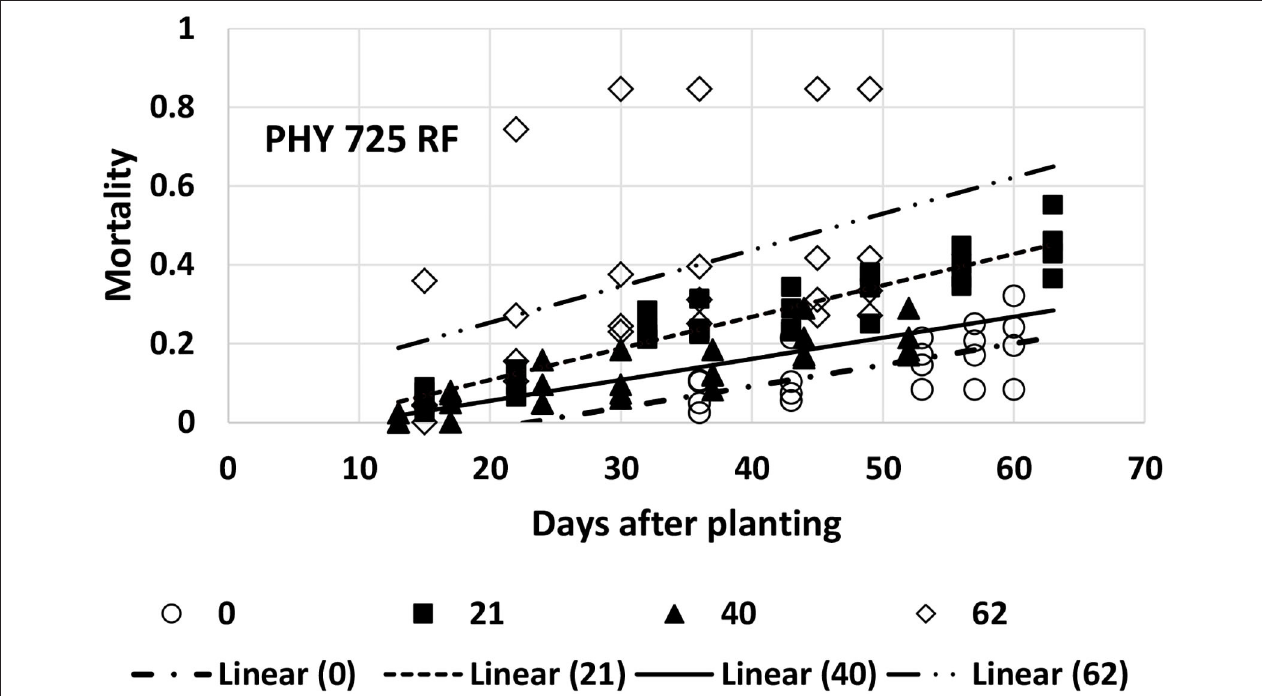
FIGURE 6 | Proportion of plants that emerged and then died (mortality) over time for PHY 725 RF at planting times of day 0, 21, 40, and 62 (day 0 occurred on 16 April) in 2021. Linear models were fitted for all four planting dates (identified as linear 0, 21, 40, or